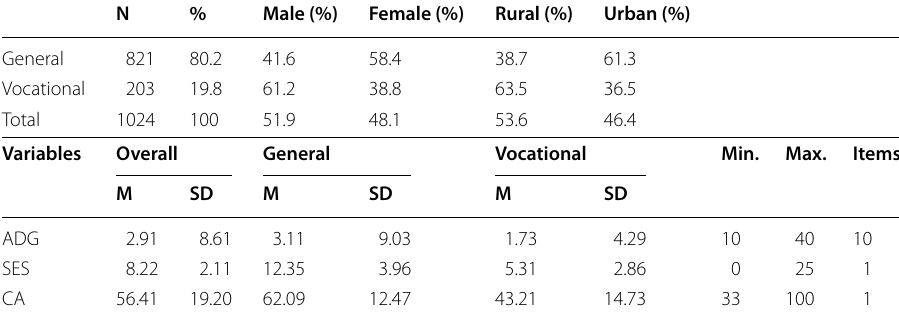
Table 1 Final sample description